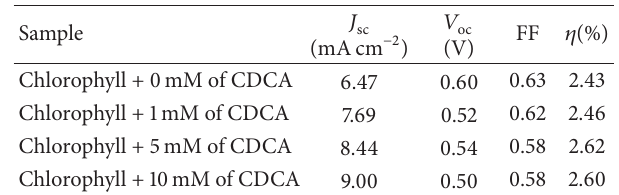
Table 5: Performance parameters of DSSCs with PVA based double salt electrolyte and chlorophyll added with various concentrations of